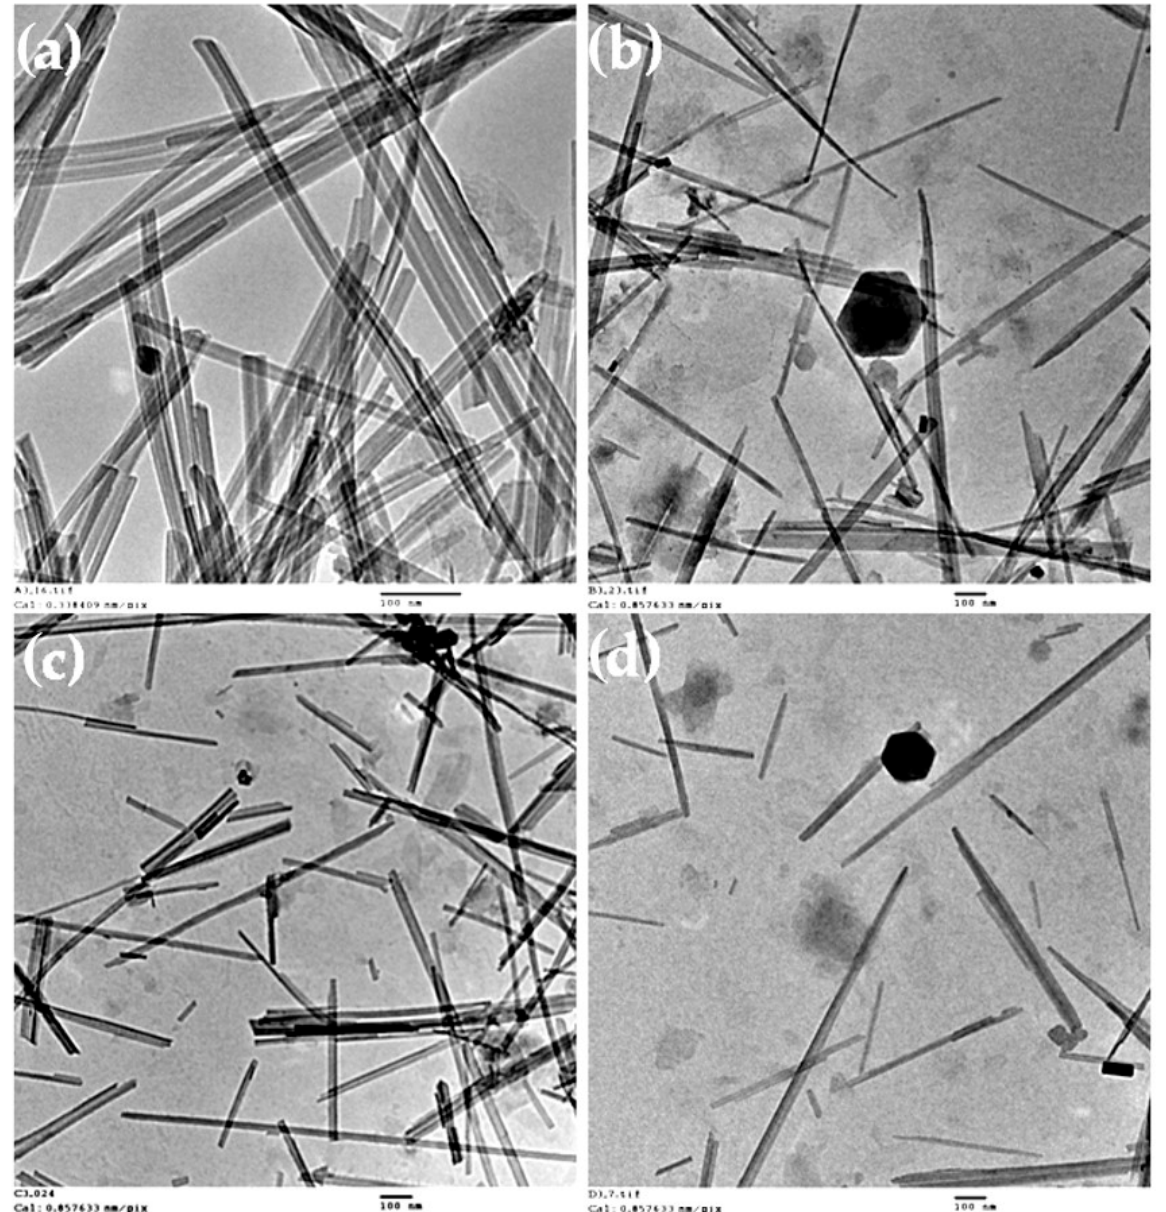
Figure 5. TEM images of 0.05 wt % palygorskite suspensions prepared using the ultrasonic probe at pH ca. 8: ( a ) without dispersing agent, ( b ) with polyphosphate, ( c ) with polyacrylate, and ( d ) with CMC. TEM of the suspension with polyacrylate was done using freshly prepared suspension, due to the high instability of this suspension with time. The scale bars represent 100 nm.